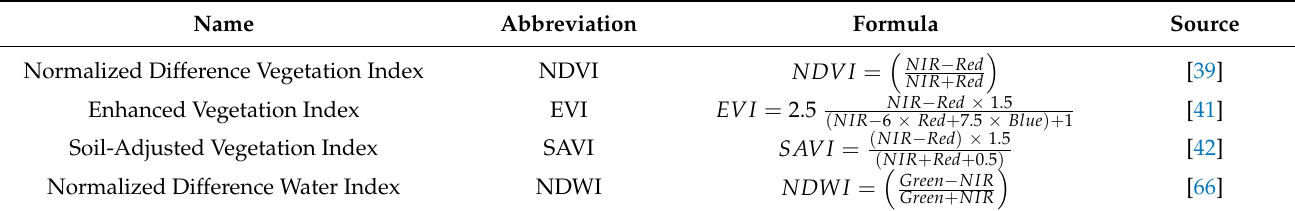
Table 2. Spectral indices used for